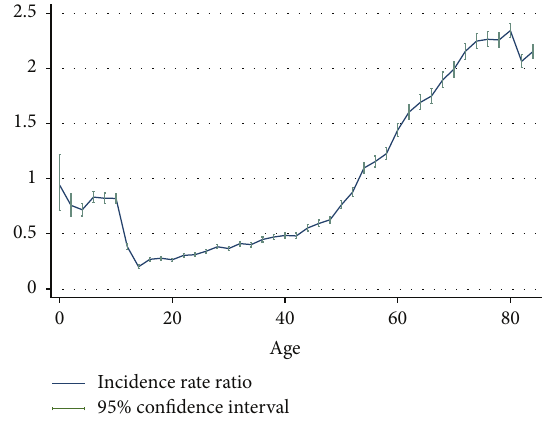
Figure 3: Age-specific female-to-male incidence rate ratios of fracture